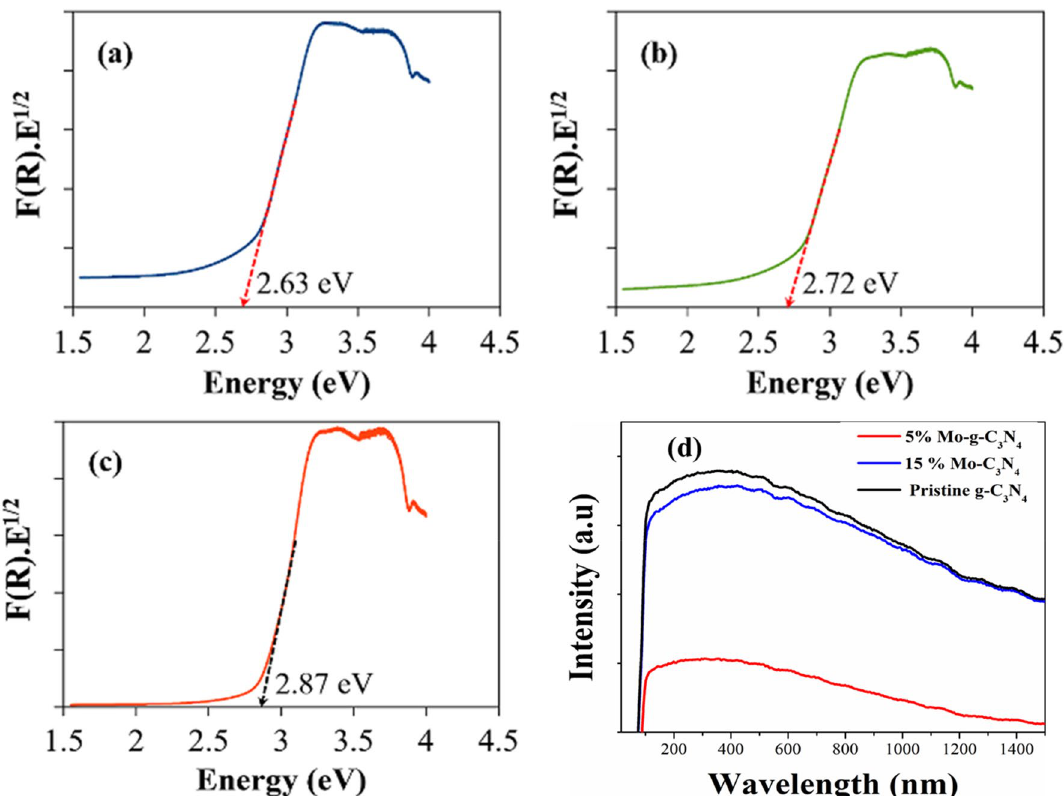
Figure 6. The bandgap energy estimation from UV–vis diffused reflectance spectroscopy of the as-prepared pristine g-C 3 N 4, and Molybdenum impregnated g-C 3 N 4 samples: ( a ) 5%Mo-CN, ( b ) pristine g-C 3 N 4 , and ( c ) 15%Mo-CN nanotubes. ( d ) The PL spectra of Pristine g-C 3 N 4 , 5% Mo-g-C3N4, and 15% Mo-g-C3N4,